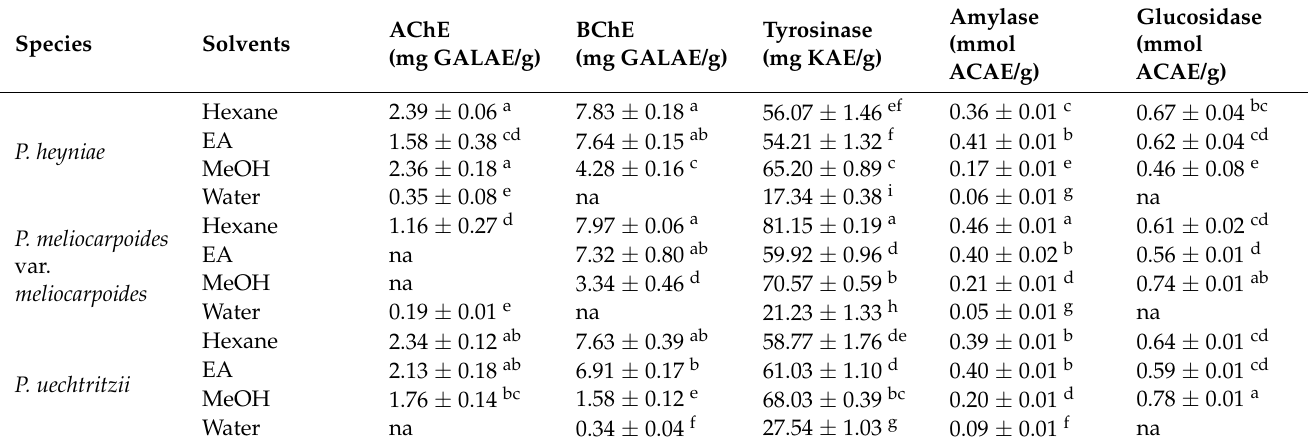
Table 4. Enzyme inhibitory effects of the tested extracts ( n =